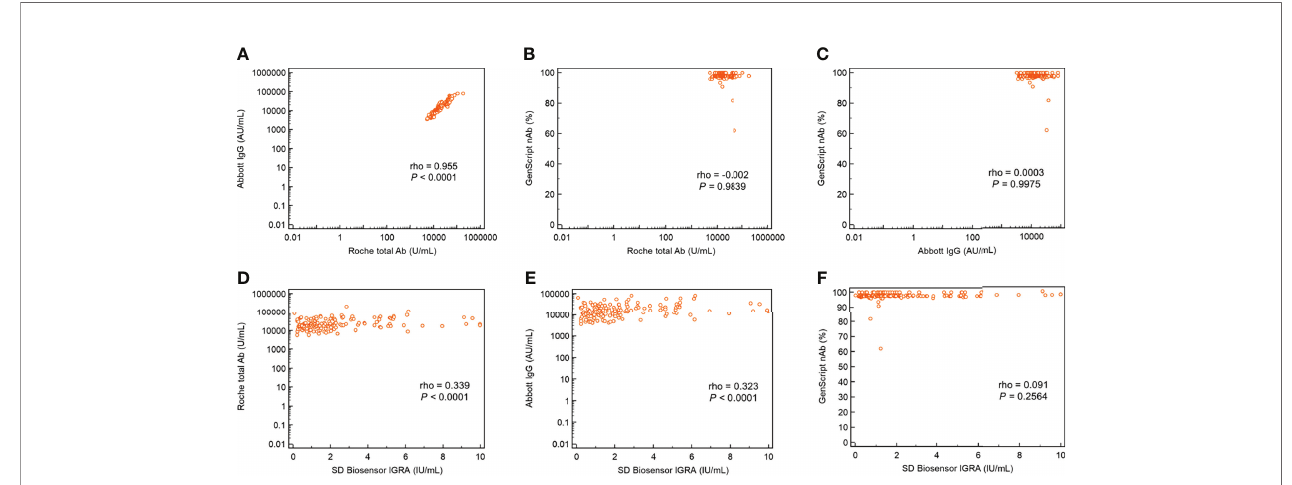
FIGURE 2 | Correlation plots with r values of the three SARS-CoV-2 antibody assays and interferon-gamma release assay for cellular response following BNT162b booster vaccination. (A) Abbott IgG versus Roche total antibody; (B) GenScript neutralizing antibody versus Roche total antibody; (C) GenScript neutralizing antibody versus Abbott IgG; (D) Roche total antibody versus SD Biosensor interferon-gamma release assay; (E) Abbott IgG versus SD Biosensor interferon-gamma release assay; and (F) GenScript neutralizing antibody versus SD Biosensor interferon-gamma release